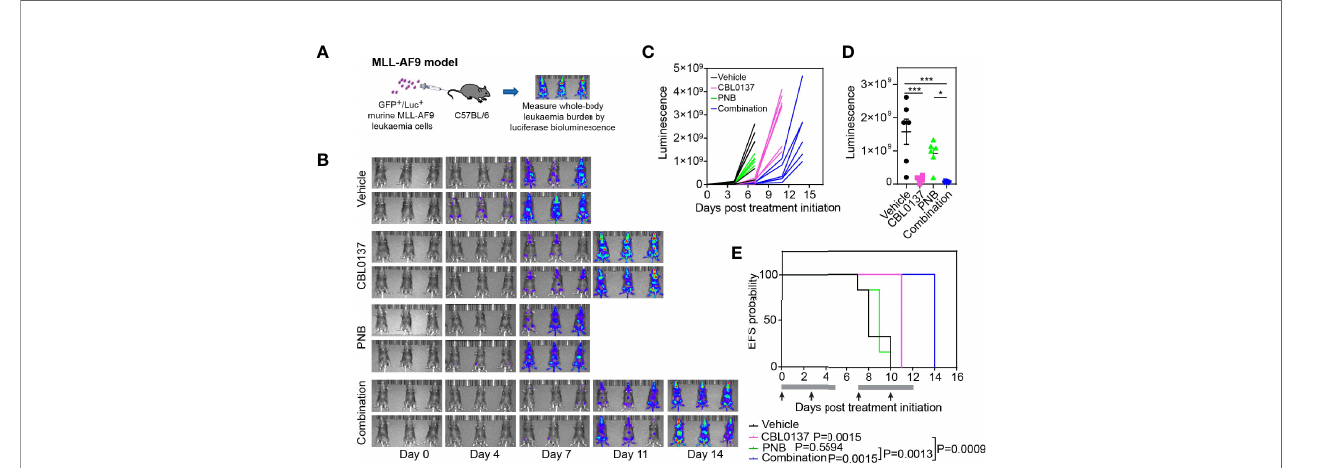
FIGURE 1 | The combination of CBL0137 and panobinostat (PNB) limits KMT2A-r acute myeloid leukemia progression. (A) Schematic of the MLL-AF9/NRas G12D AML mouse model. (B) Whole body bioluminescence imaging at different time points after MLL-AF9/NRas G12D leukemia cell inoculation. (C) Quanti fi cation of whole- body bioluminescent imaging in individual mice. (D) Comparison of whole-body bioluminescent signal on day 8 after inoculation. Each dot corresponds to the signal in one mouse. The signi fi cance of the difference between group mean signals was determined by ANOVA followed by Tukey ’ s multiple comparison test. (E) Kaplan- Meier survival plot. The solid bar below the survival graphs represents treatment duration for PNB and arrows indicate CBL0137 administration. The Gehan-Wilcoxon test was used to compare survival between treatment groups. P-values comparing survival of control and treatment groups are denoted directly next to the legend. Statistical data displayed at the top of a bar in the graphs correspond to comparisons with controls. Asterisks represent signi fi cance levels of P values: *P < 0.05, ***P <